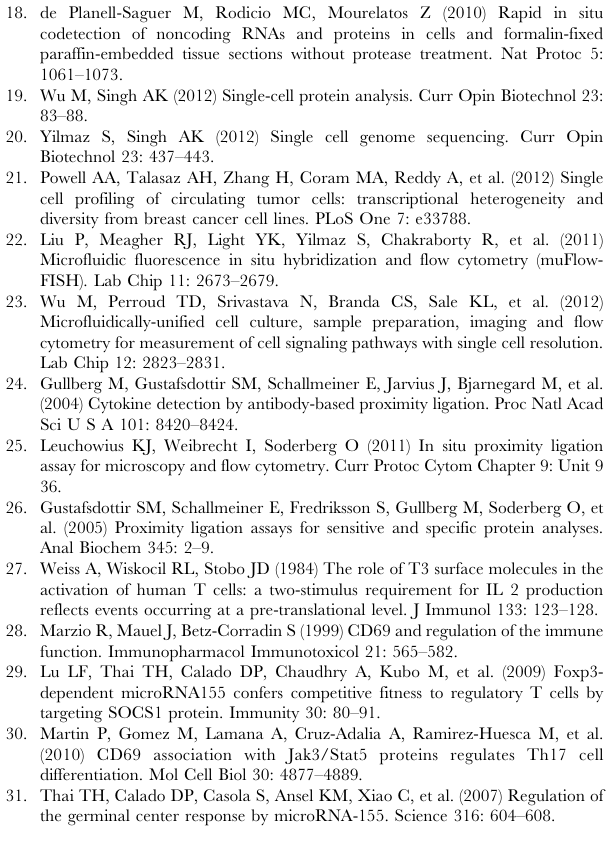
Figure S3 Scatter plot of Jurkat cells after 24 h of PMA and Ionomycin activation, showing heterogeneity of CD69 and miR155 expression levels in individual